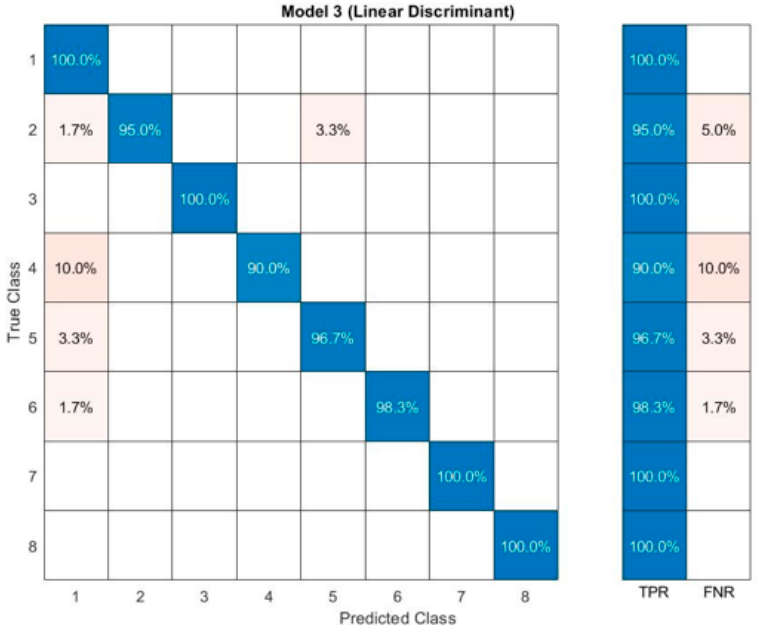
Figure 9. Linear-discriminant-model confusion matrices.